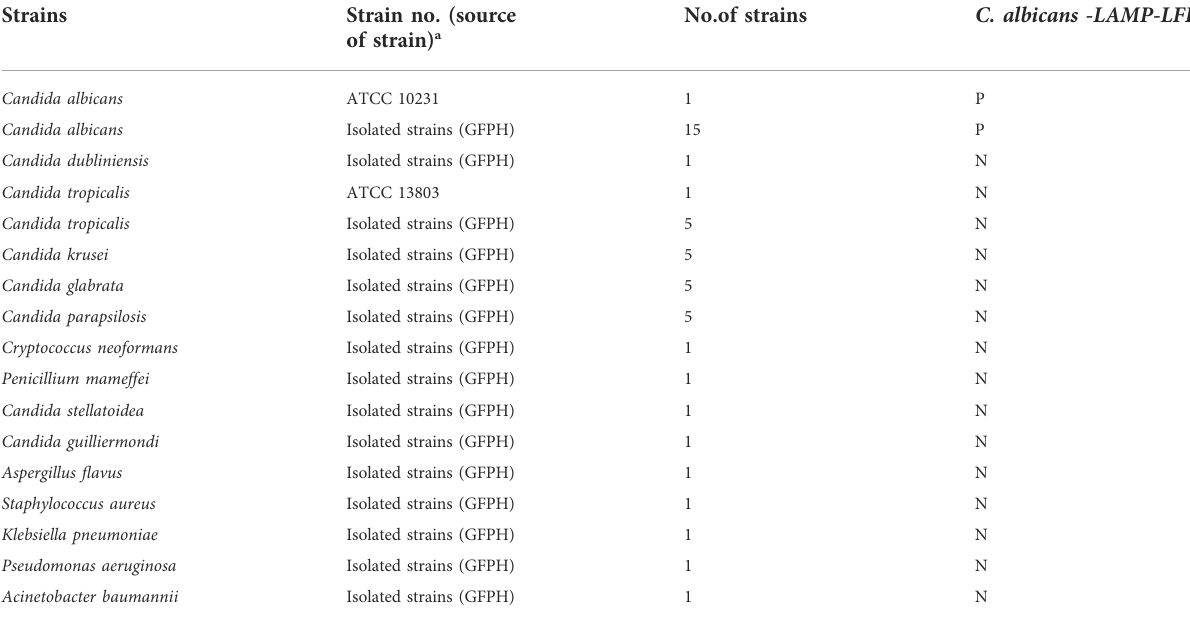
TABLE 2 Fungi and bacteria strains used in the